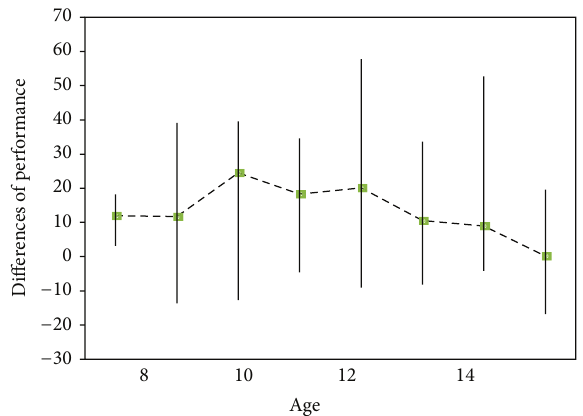
Figure 2: Differences of performance in monadic and dyadic contexts to show the effect of context on biological motion detection across